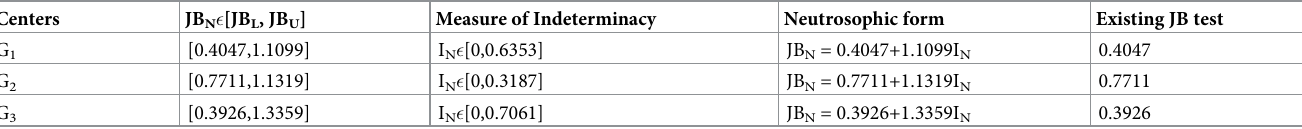
Table 2. The measures of indeterminacy associated with the test.